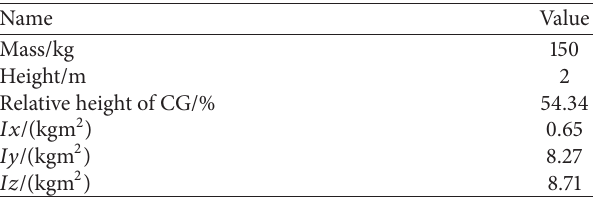
Table 2: Physical parameters of dummy